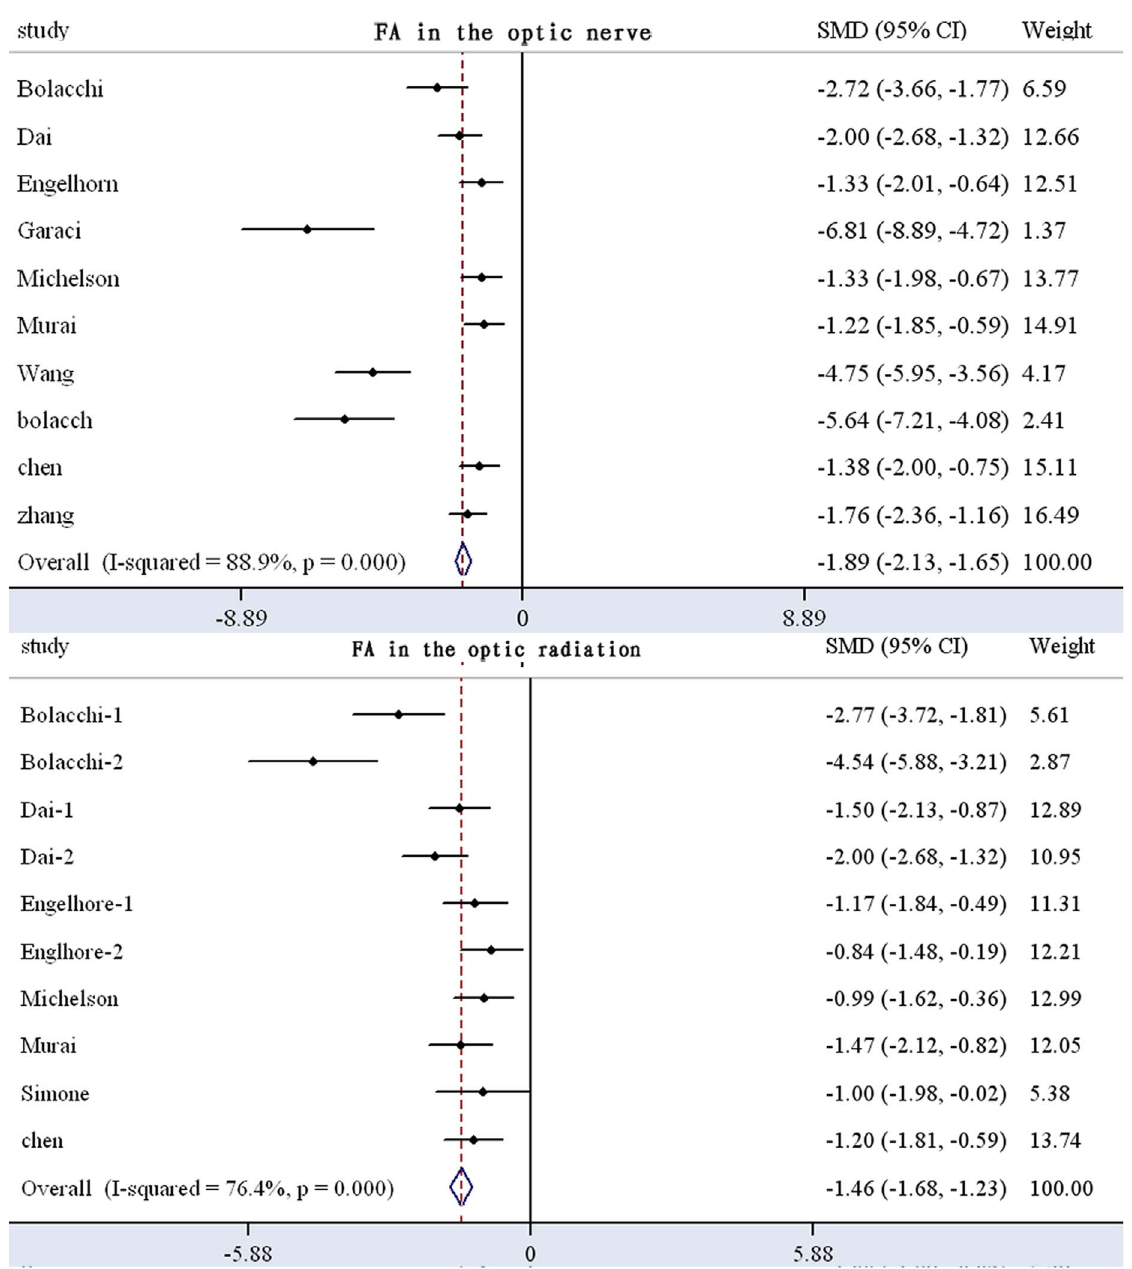
Figure 3. Meta-analysis results of FA in the optic nerve and optic radiation in patients with glaucoma compared with controls (data from Table 2). There is an apparent trend toward high heterogeneity (P , 0.05, and the diamond shape meaning significant difference appears on the left side;I 2 . 50%). FA: fractional anisotropy; SMD: standardized mean difference; CI: confidence interval.